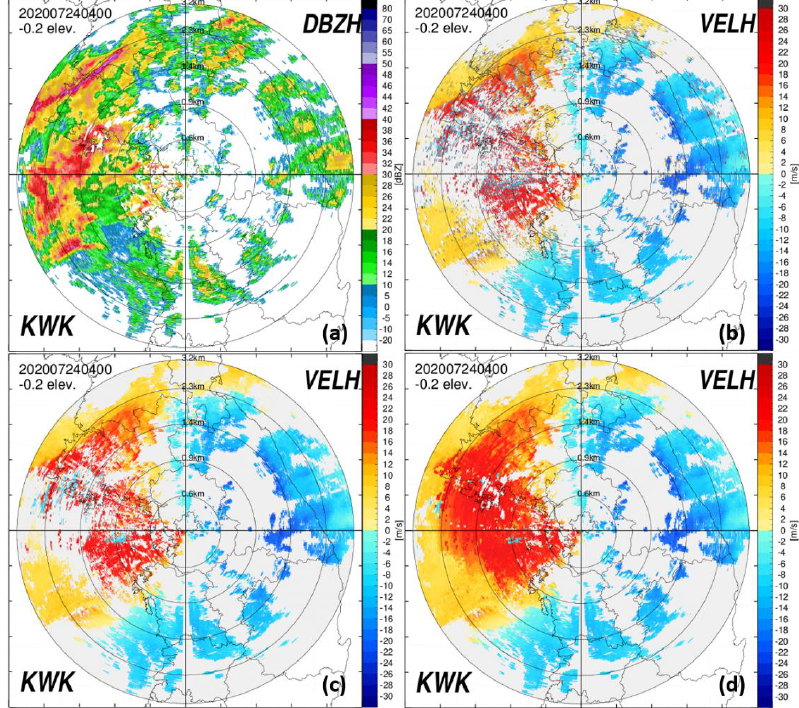
Figure 10. PPIs at the elevation angle of −0.2° of KWK at 0400 LST on 24 July 2020; ( a ) radar reflectivity, ( b ) raw radial velocity, ( c ) radial velocity field after noise correction, and ( d ) radial velocity after noise correction and restoration of lost radial velocity.